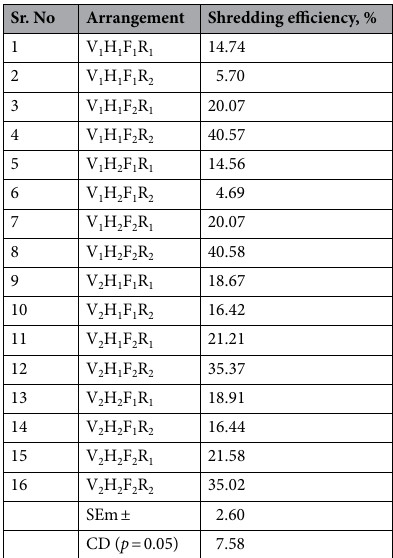
Table 15. Effect of both speed and vertical adjustment and horizontal adjustment on shredding efficiency.